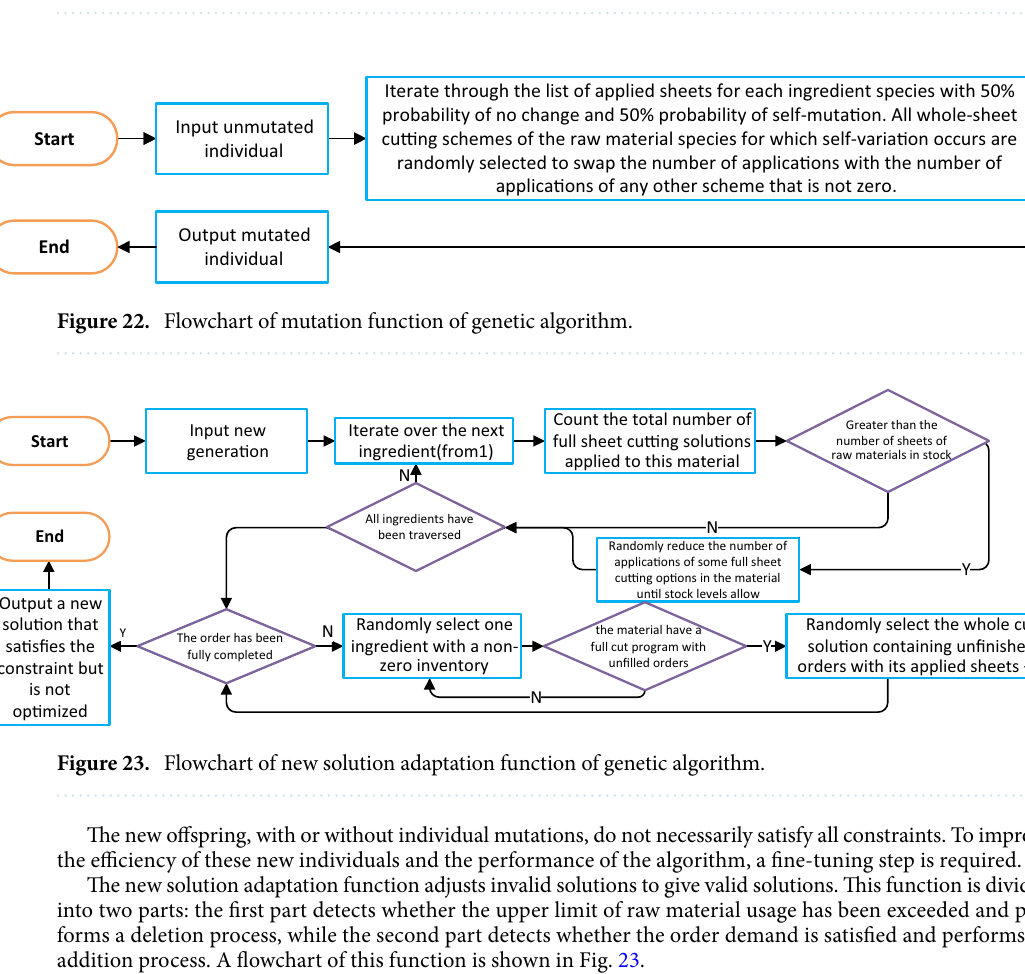
Figure 21. Schematic diagram of offspring generation.